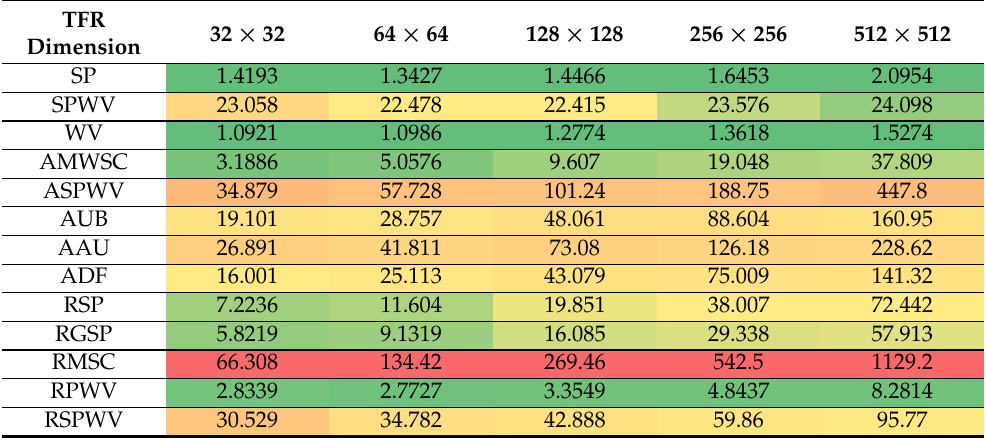
Table 13. Computational time for analyzed TFRs of different dimensions for a noisy linear FM signal with 128 time samples (averaged over 100 realizations, SNR of 5 dB), cell colors range from green for the best result to red for the worst result in each column respectively, in milliseconds (ms). TFR 32 × 32 64 × 64 128 × 128 256 × 256 512 × Dimension